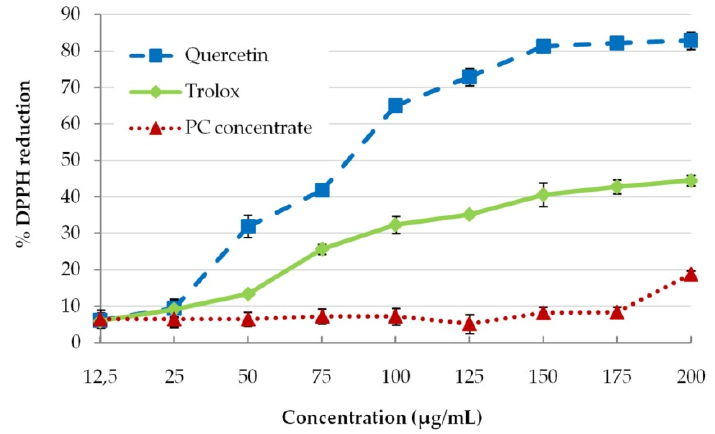
Table 3. Half maximal effective concentration (EC 50 ) for PC concentrate, trolox and quercetin for DPPH radical scavenging activity.